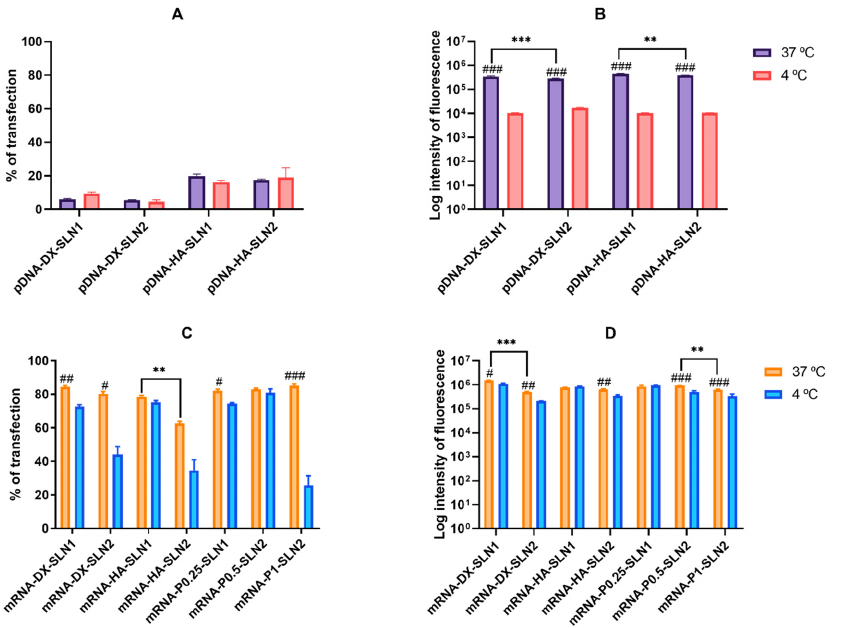
Figure 4. Percentage of transfected cells and intensity of fluorescence of HEK-293 cells after incubation with SLN1- and SLN2-based vectors at 37 and 4 °C. Data are expressed as mean ± standard deviation; n = 3. ( A ) Percentage of transfected HEK-293 cells 72 h after treatment with pDNA vectors. ( B ) Intensity of fluorescence of transfected HEK-293 cells 72 h after treatment with pDNA vectors. ( C ) Percentage of transfected HEK-293 cells 48 h after treatment with mRNA vectors. ( D ) Intensity of fluorescence of transfected HEK-293 cells 48 h after treatment with mRNA vectors. # p < 0.05 with respect to the same vector at 4 °C. ## p < 0.01 with respect to the same vector at 4 °C. ### p < 0.001 with respect to the same vector at 4 °C. ** p < 0.01 with respect to the other formulation. *** p < 0.001 with respect to the other formulation.